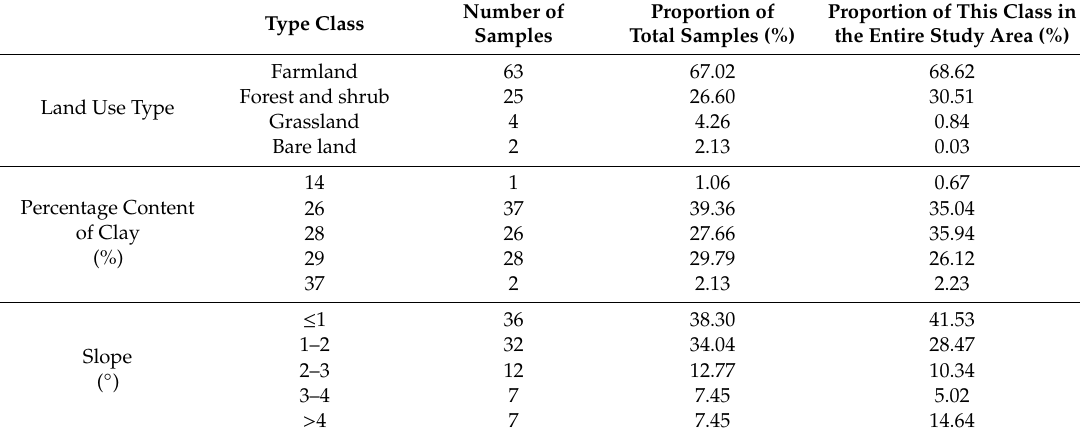
Table 1. Detailed information of the 94 samples taken from a study area in Jiangsu Province,